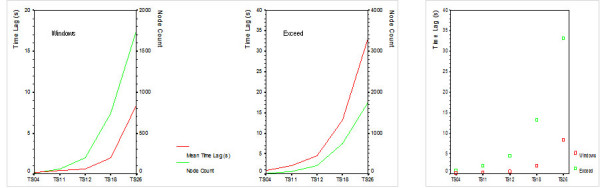
System response time with load for the 2D browser. Plots showing the exponential increase in system response time with data load for the 2D browser.